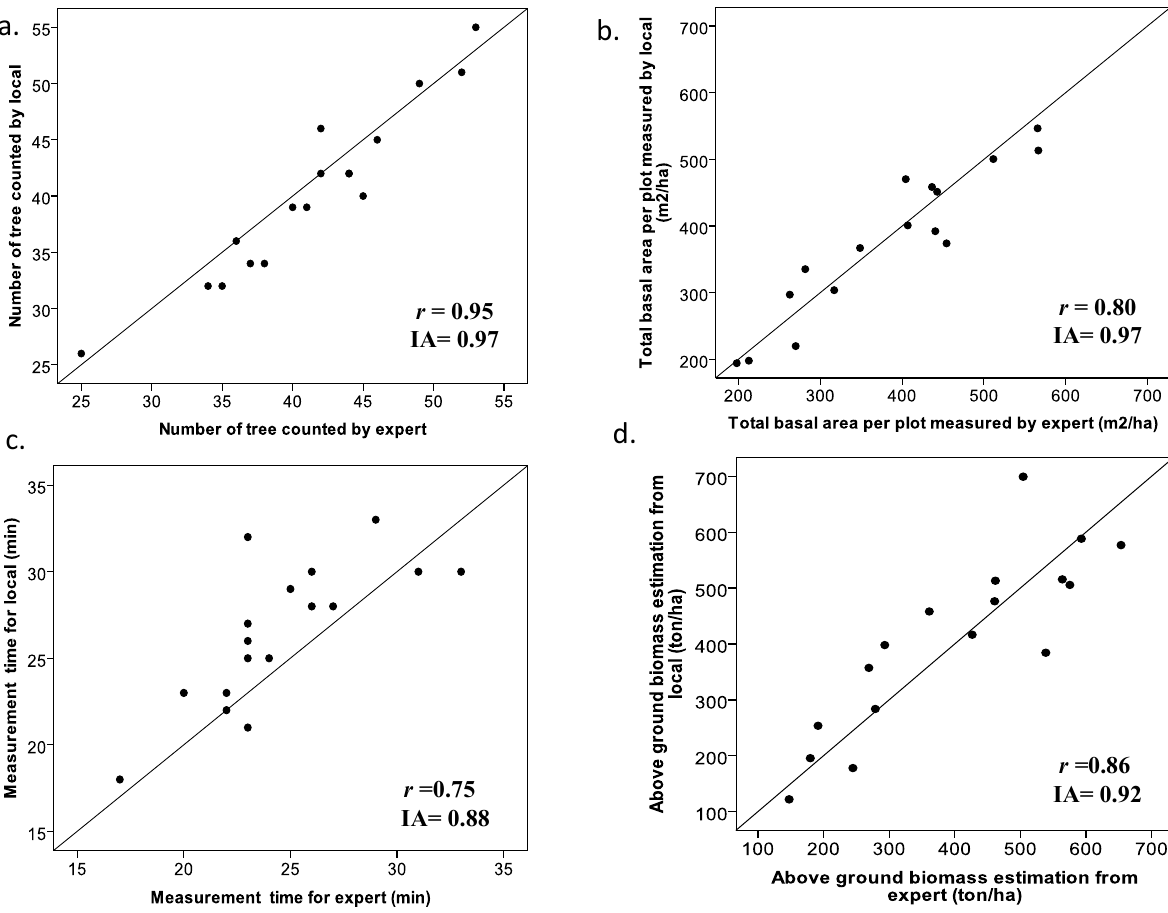
Figure 5. Simple linear correlation and error analysis statistics of the comparison between local (dependent variable y) and expert estimated (independent variable x) for: ( a ) Number of tree; ( b ) Total basal area per plot; ( c ) measuring time and ( d ) above ground biomass estimation. r is the linear correlation parameter, and IA is the index of